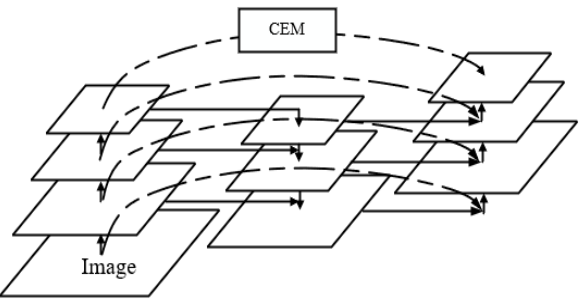
Figure 5. The structure of R-FPN.